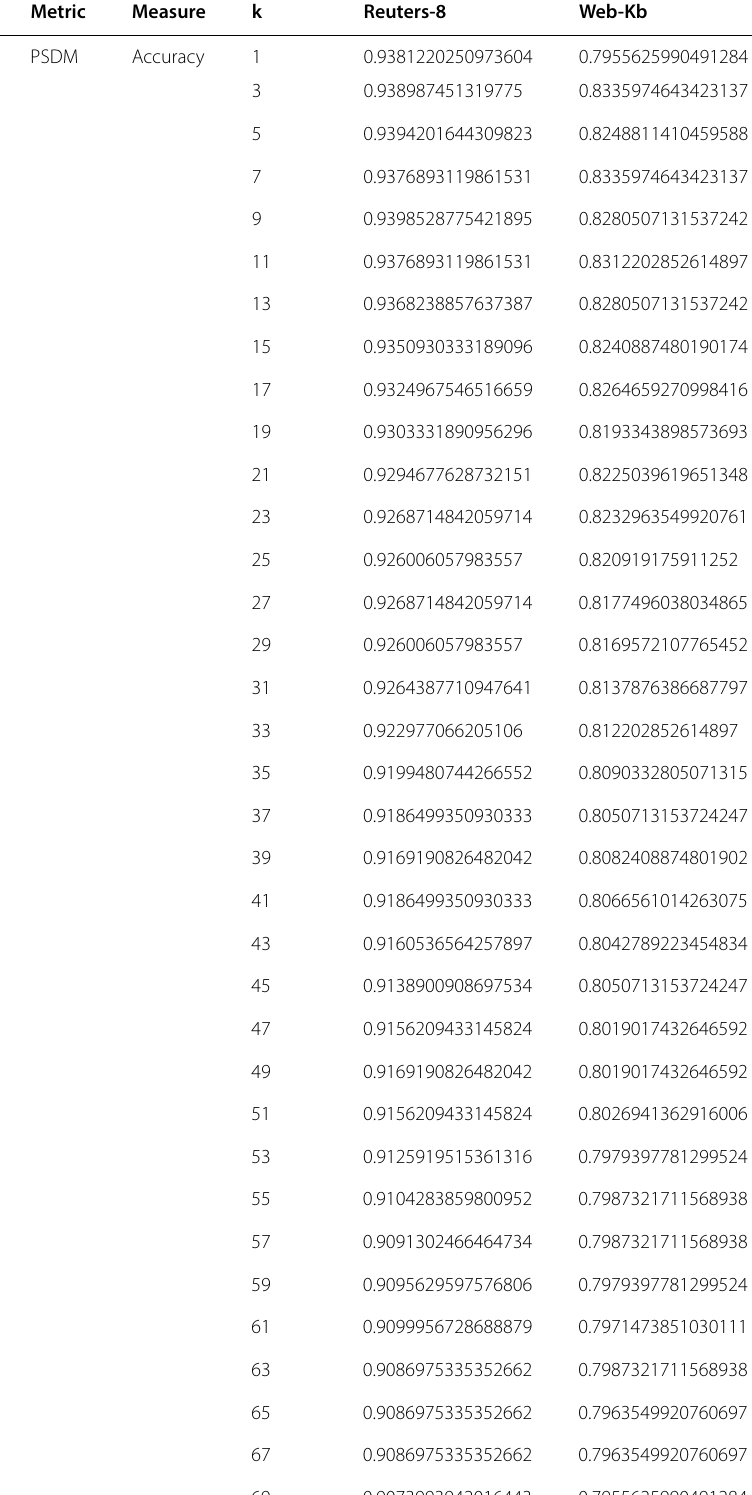
6000 on both datasets =